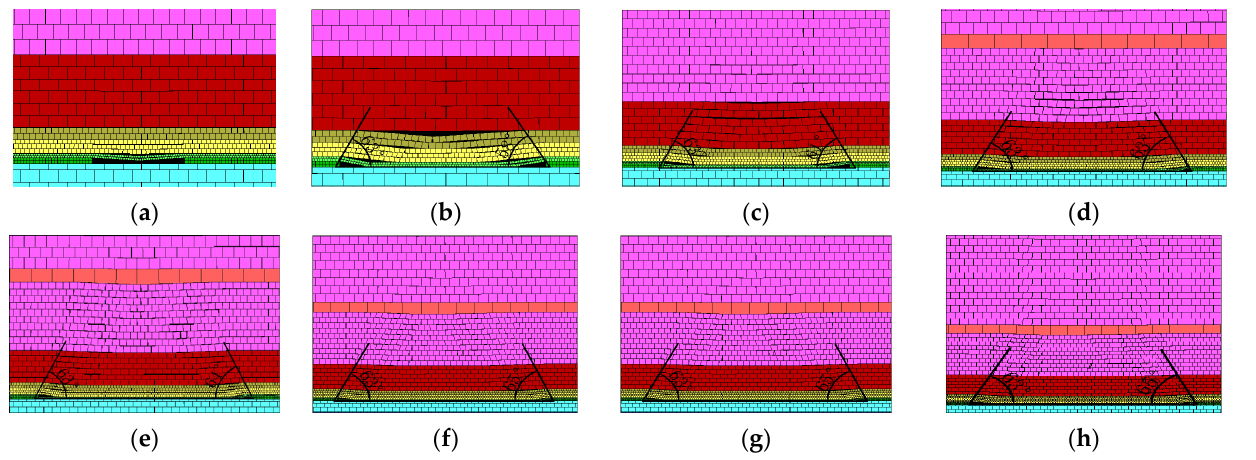
Figure 3. Overlying strata movement with the different advance distance of working face. ( a ) Working face advance 50 m. ( b ) Working face advance 100 m. ( c ) Working face advance 150 m. ( d ) Working face advance 200 m. ( e ) Working face advance 250 m. ( f ) Working face advance 300 m. ( g ) Working face advance 350 m. ( h ) Working face advance 400 m.